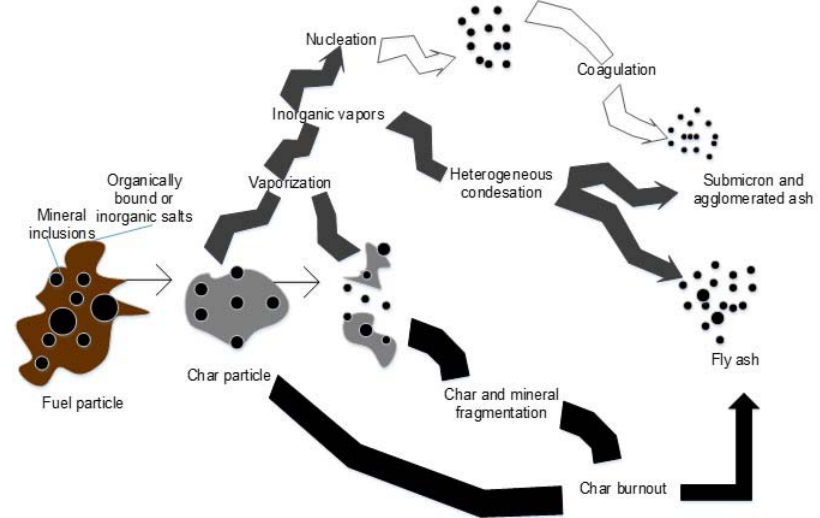
Figure 1. Physical transformation in ash formation during combustion of coal/biomass, Reproduced with permission from Cieplik, M.K.; Fryda, L.E.; van de Kamp, W.L.; Kiel, J.H.A. Solid Biofuels for Energy: A Lower Greenhouse Gas Alternative ; Springer: London, UK, 2011 (Ref. [5] p. 198). Lignite fly ash is subject to comparatively larger fluctuations compared to coal ashes [6].